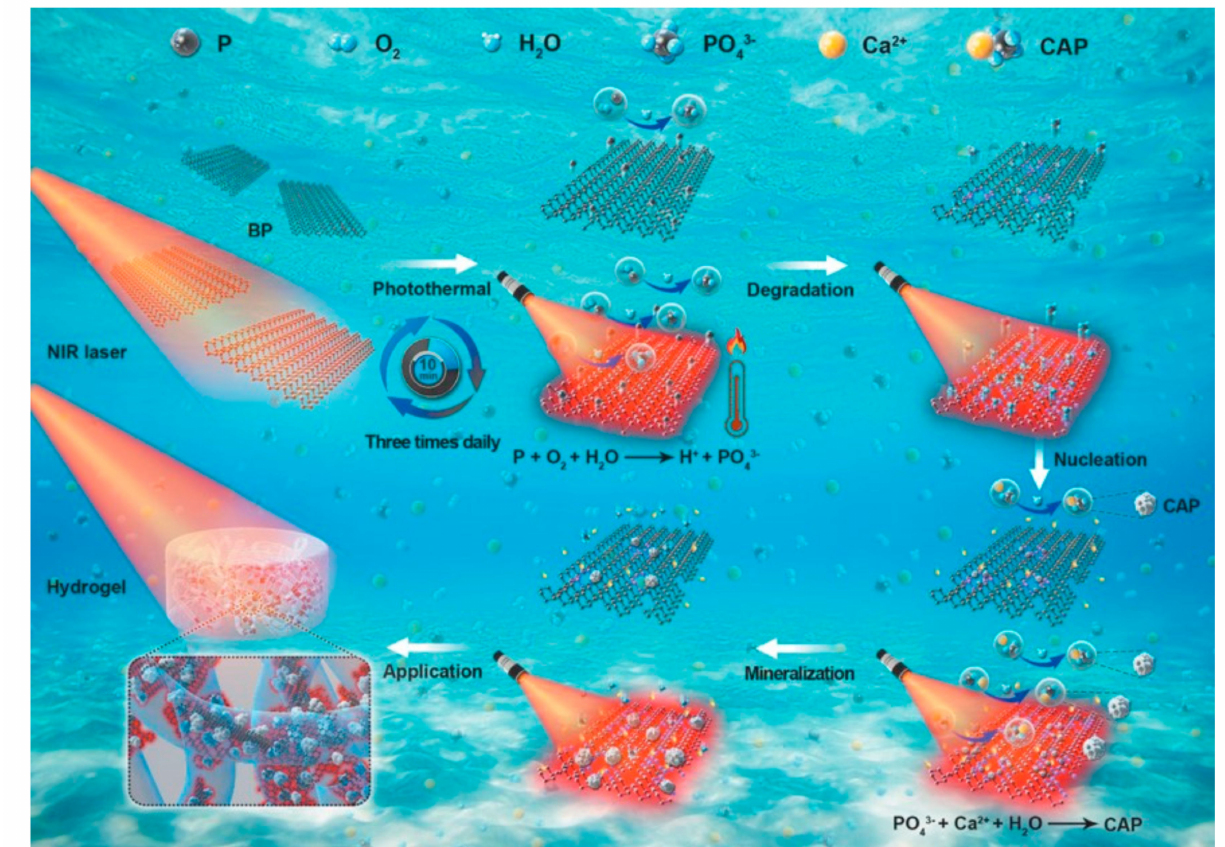
Figure 4. Mechanism of in situ mineralization of BP/agarose hydrogels under NIR irradiation [124]. Copyright 2020,